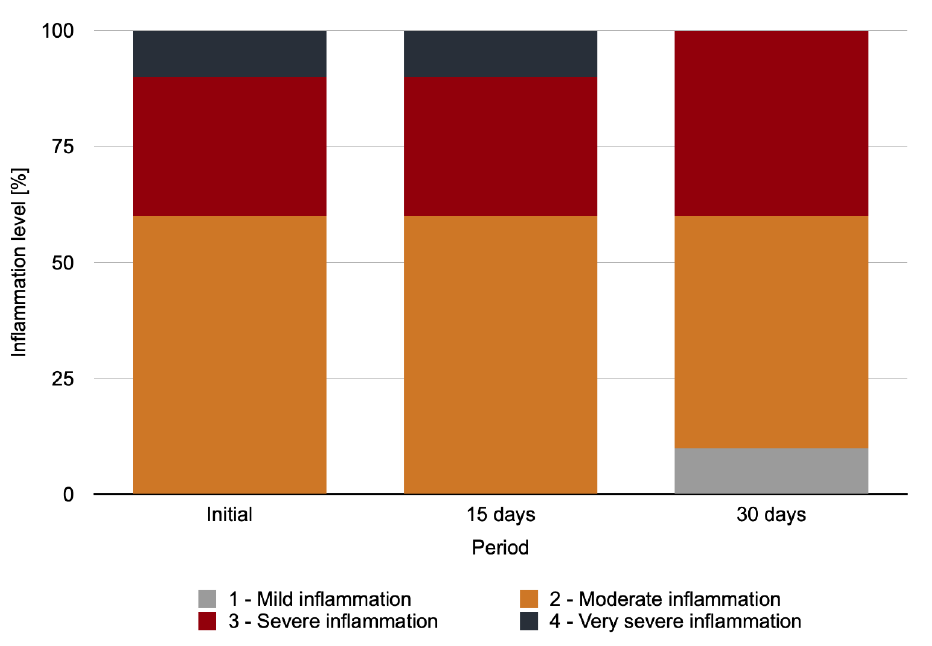
Figure 5. Percent distribution of the level of palpebral conjunctiva inflammation in the anophthal- mic socket over time in the IG.